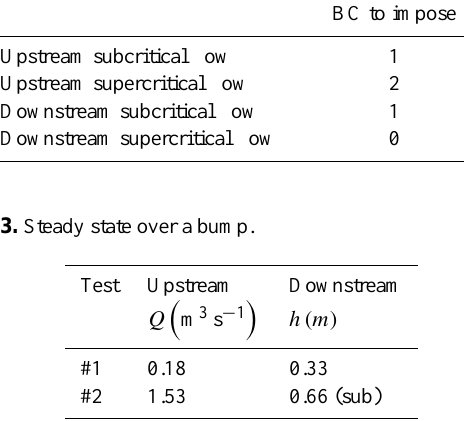
Figure 4. Steady state over a bump. Initial state (dashed line). Bed level (grey). Numerical solution (blue): (a) Test #1; (b) Test #2. Table 2. Boundary conditions. Flow regime and boundary